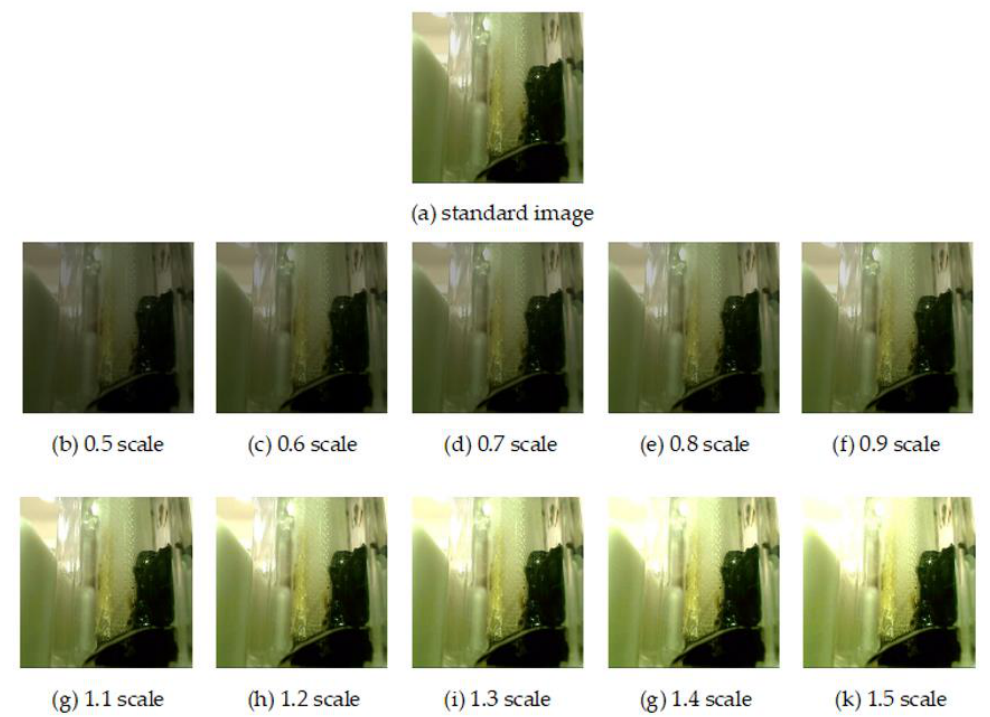
Figure 5. Feces images under different illuminations.